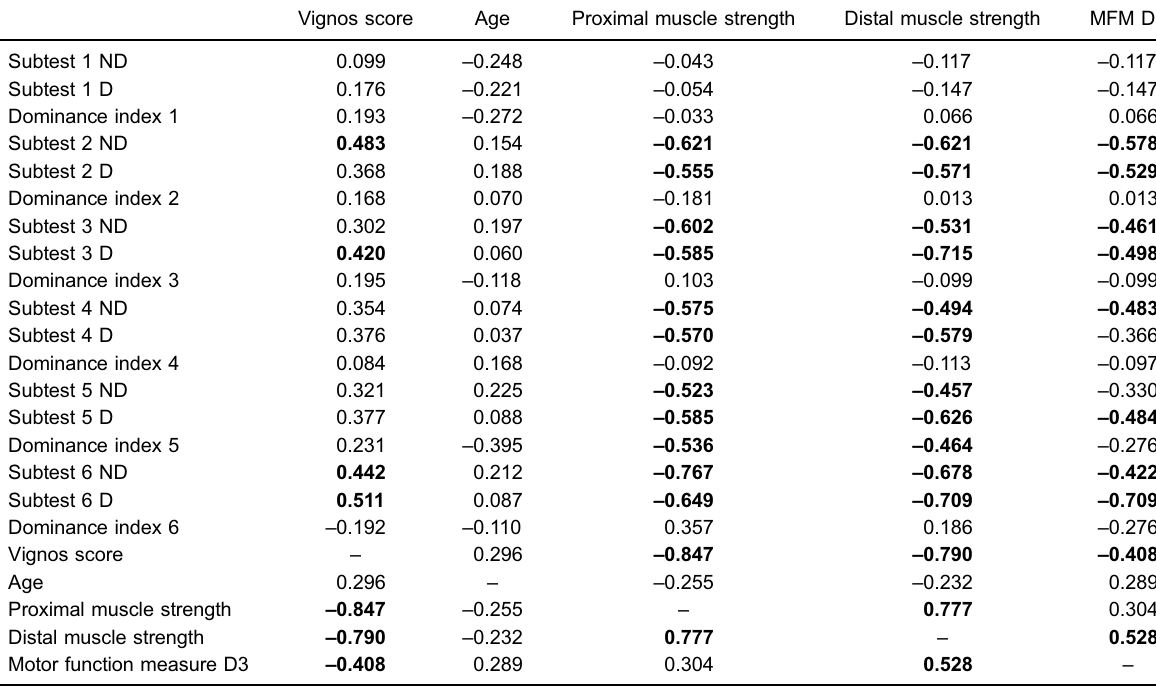
Table 4. Correlations (r) between proximal and distal upper limb muscle strength, subtests of Jebsen-Taylor Test, and scores of dimension 3 of Motor Function Measure (MFM